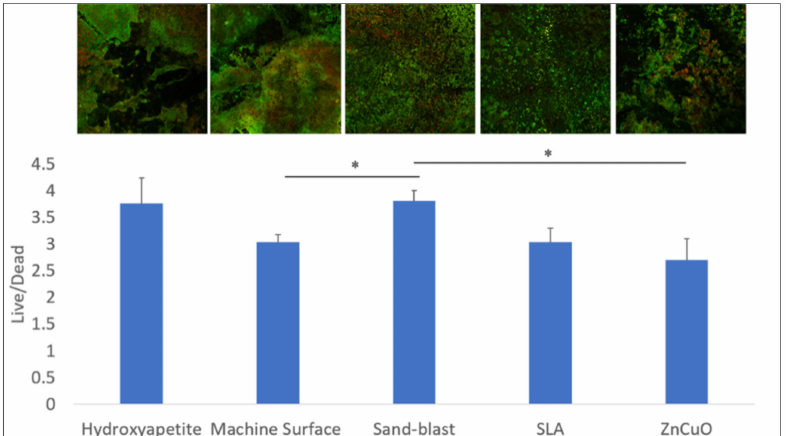
Figure 4. Confocal microscopy analysis of the live/dead assay in the biofilms grown on machined, sandblasted, SLA, and ZnCuO-coated titanium surfaces and hydroxyapatite discs after 14 days. Images showing staining of live bacteria in green and dead bacteria in red; bars showing the ratio of live to dead bacteria, expressed as the mean + SD ( n = 4; asterisk indicates p < 0.05). Osteoblast-like cell proliferation (XTT assay) on hydroxyapatite, sandblasted, SLA, and ZnCuO-coated surfaces was 1.1-, 1.23-, 1.31-, 1.4-fold higher than that on the machined control surface, respectively (Figure 5a). ALP activity was significantly higher in the cells cultured on the ZnCuO-coated and sandblasted surfaces than on the machined surface (1.2- and 1.19-fold, respectively) (Figure